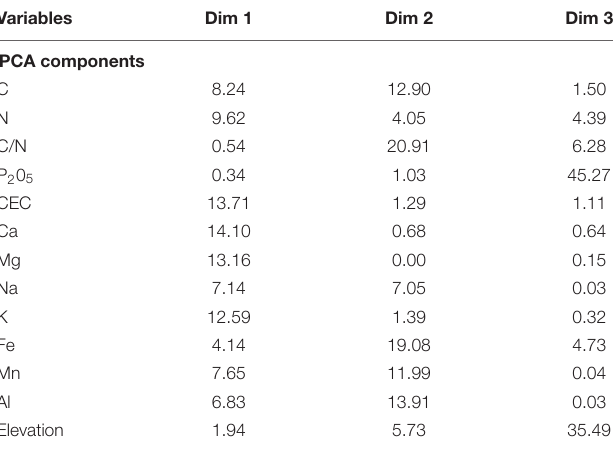
TABLE 1 | Variable contributions (%) to the first three axis of the PCA of local descriptors.